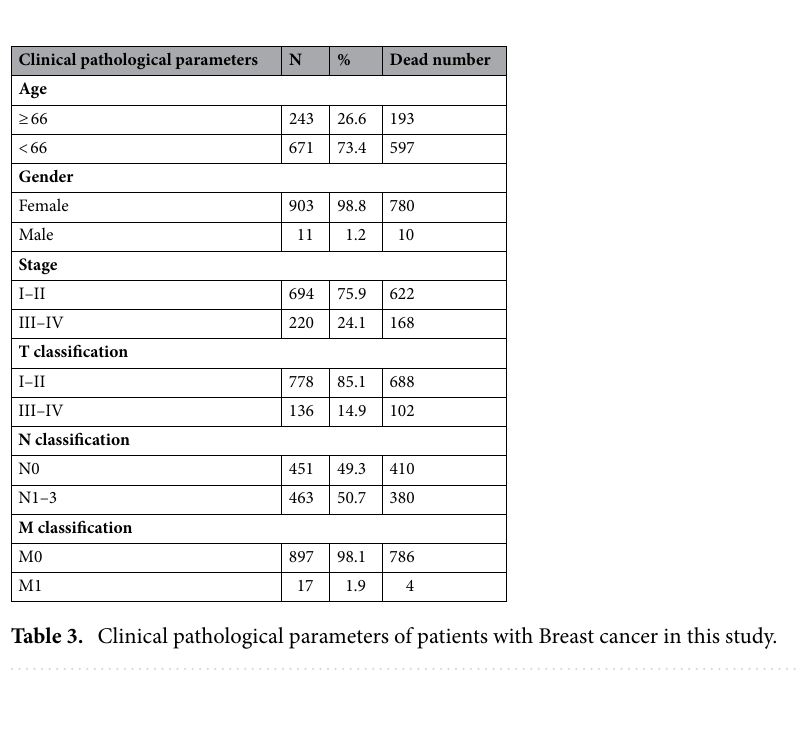
Figure 4. Time-dependence ROC curve according to the 5-year survival of the area under the AUC value.